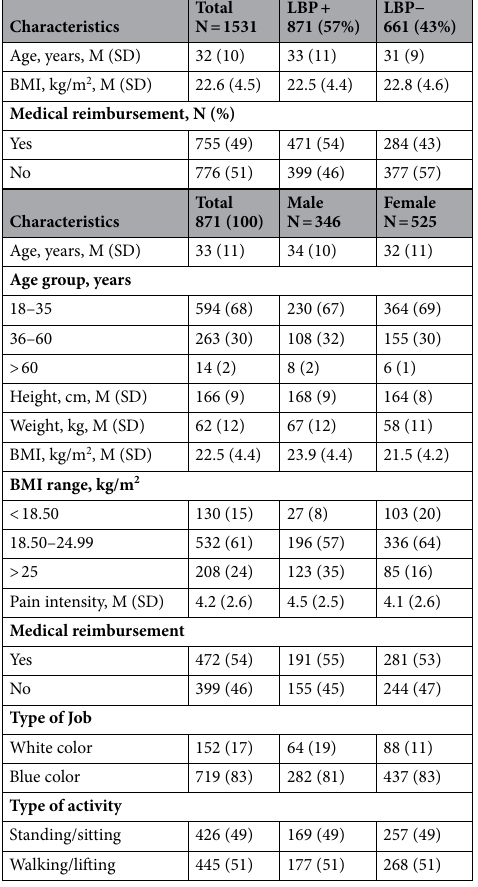
Table 1. Baseline sociodemographic characteristics. M (SD): mean (standard deviation), N (%): number (percentage), BMI: body mass index. Data represented as mean (standard deviation) unless otherwise specified N (%). * p < 0.05.